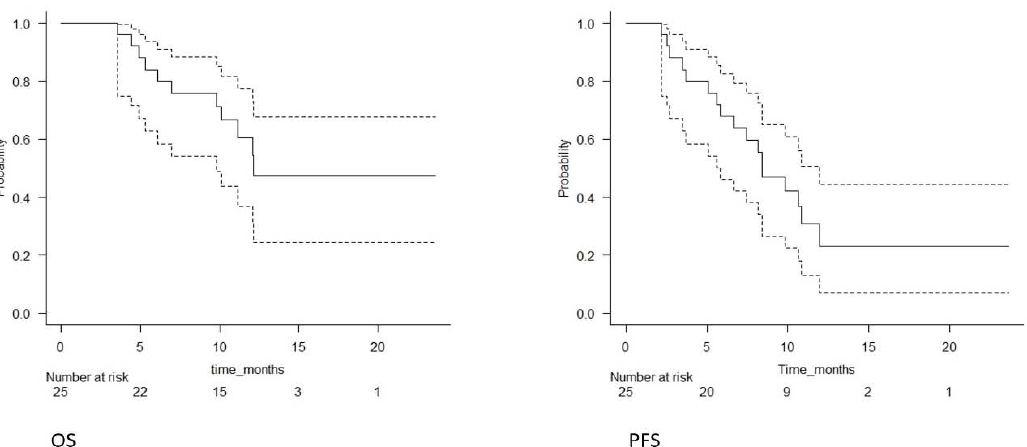
Figure 2. Overall survival and progression-free survival of the entire population (solid lines); confidence intervals (dotted lines).